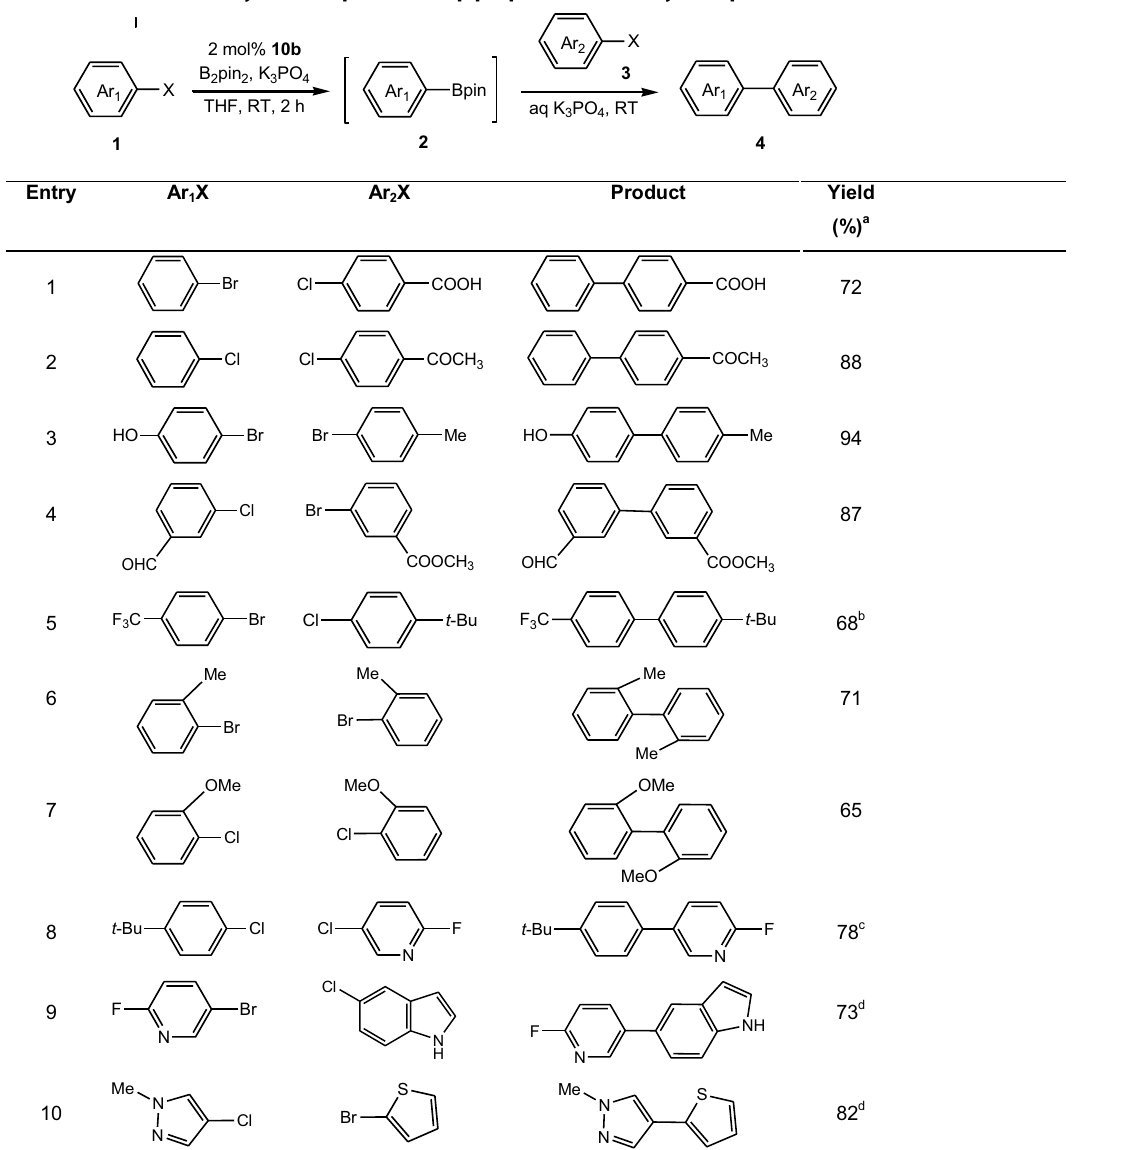
Table 3 Palladium-catalyzed one-pot two-step preparation of biaryl